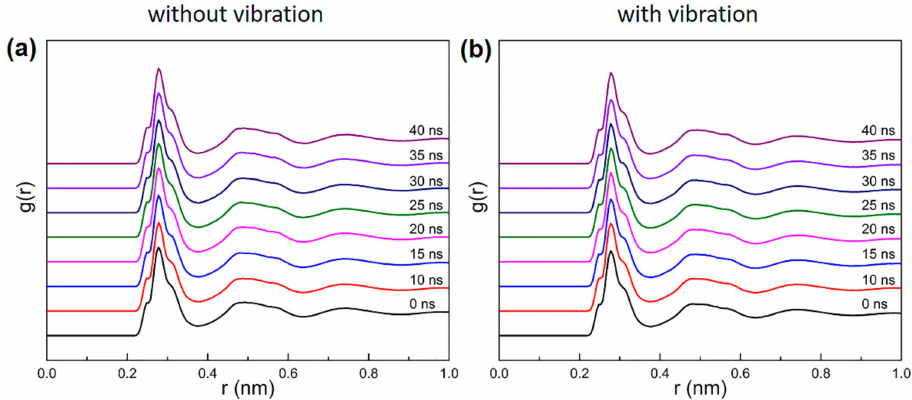
Figure 7. Radial distribution functions of metallic glasses (MGs) during tension, ( a ) without vibrational loading and ( b ) with vibrational